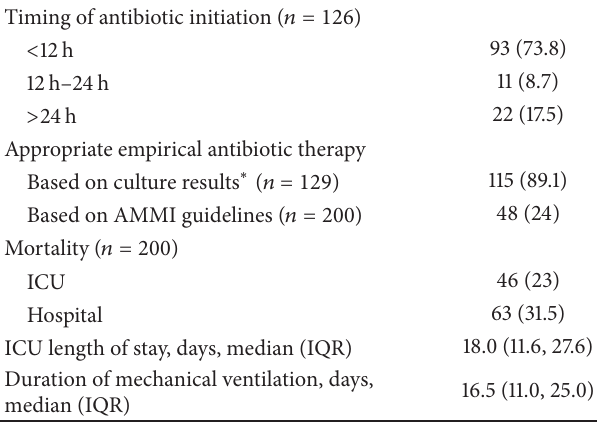
Table 4: Antibiotic utilization and patient outcomes.